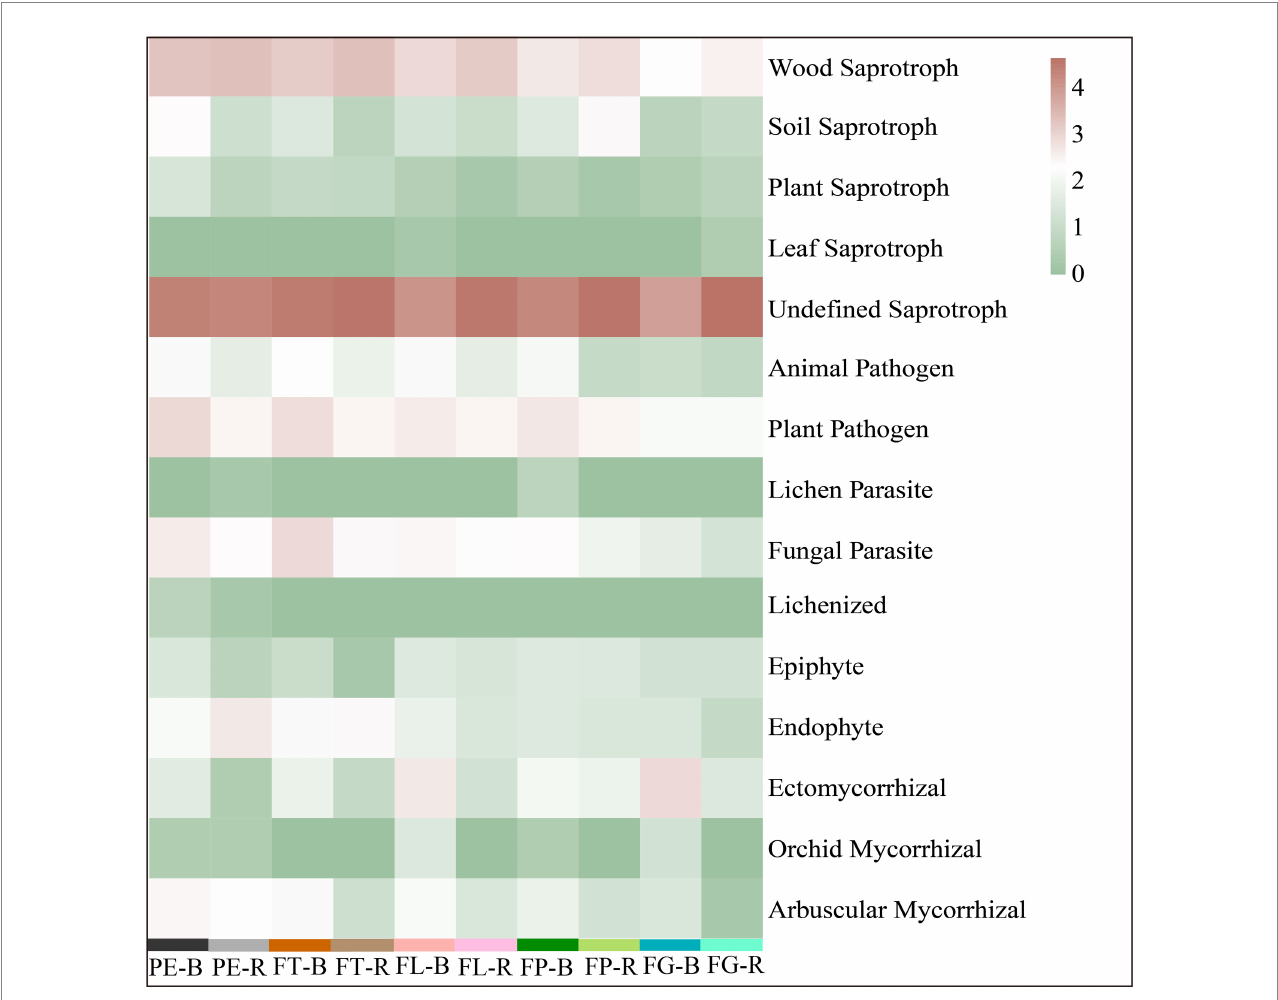
FIGURE 6 Prediction of the fungal functional guild based on the FUNGuild database. Rhizosphere soil (R): PE-R, Phyllostachys edulis ; FT-R, P. edulis f. tao kiang ; FL- R, P. edulis f. luteosulcata ; FP-R, P. edulis f. pachyloen ; FG-R, P. edulis f. gracilis . Bulk soil (B): PE-B, P. edulis ; FT-B, P. edulis f. tao kiang; FL-B, P. edulis f. luteosulcata; FP-B, P. edulis f. pachyloen ; FG-B, P. edulis f. gracilis